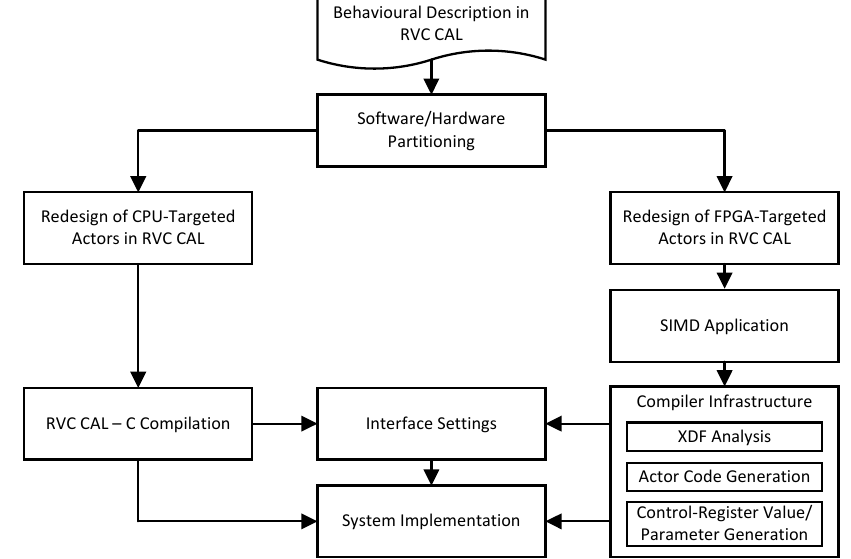
Figure 3. A brief description of the design flow of a hardware and software heterogeneous system highlighting key features. More detail of the flow is contained in reference